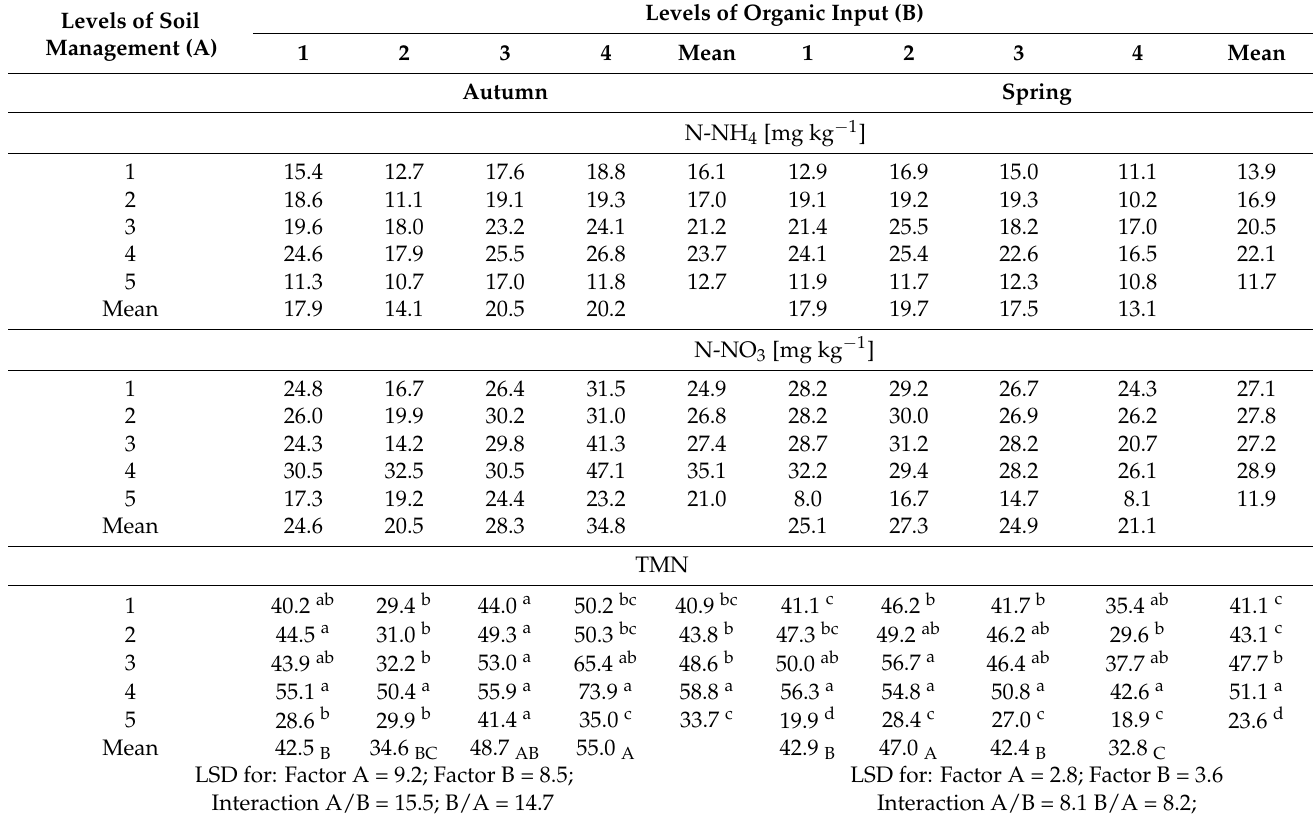
Interaction A/B = 15.5; B/A = 14.7